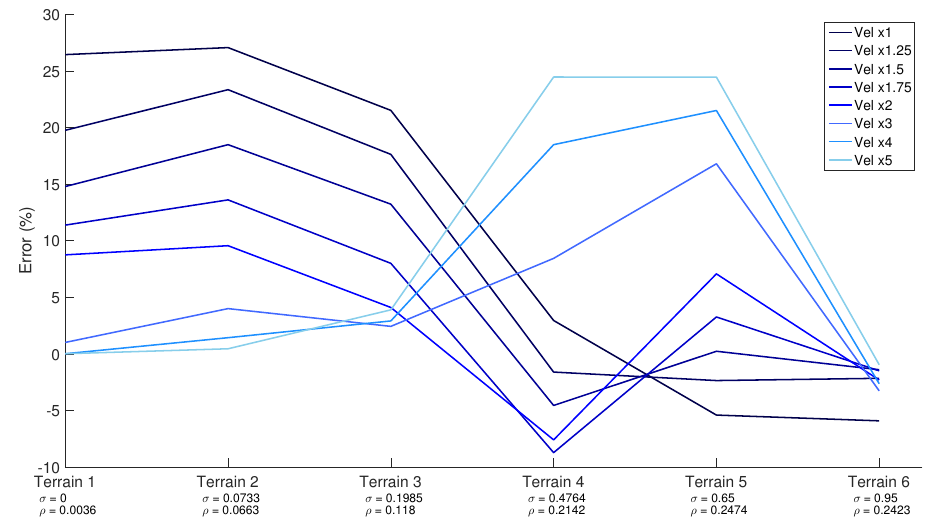
Figure 13. Errors of the slip estimator for different terrains and velocities during the acceleration steps. Analysing terrains 1 to 3, there are high errors for high velocity increments, and low errors for low velocity increments. The contrary happens for terrains 4 to 6. A balance between errors for different parameters arise with velocity